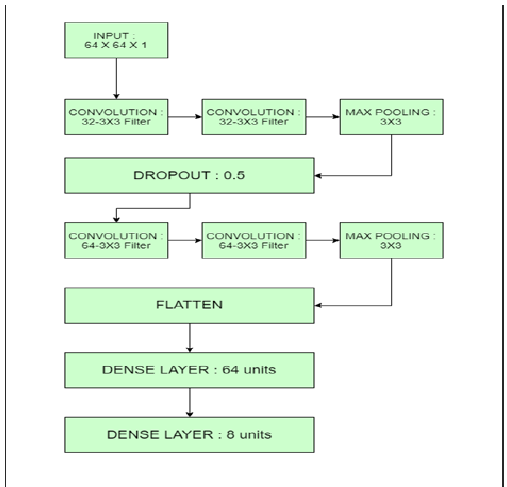
Figure 2. CNN Architecture for the